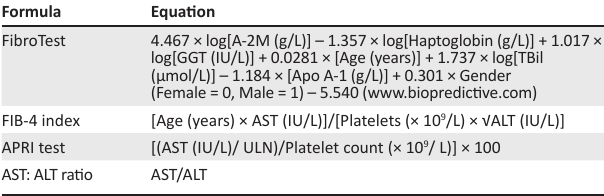
TABLE 1: Formulae of non-invasive algorithms for detection of fibrosis used in the study.